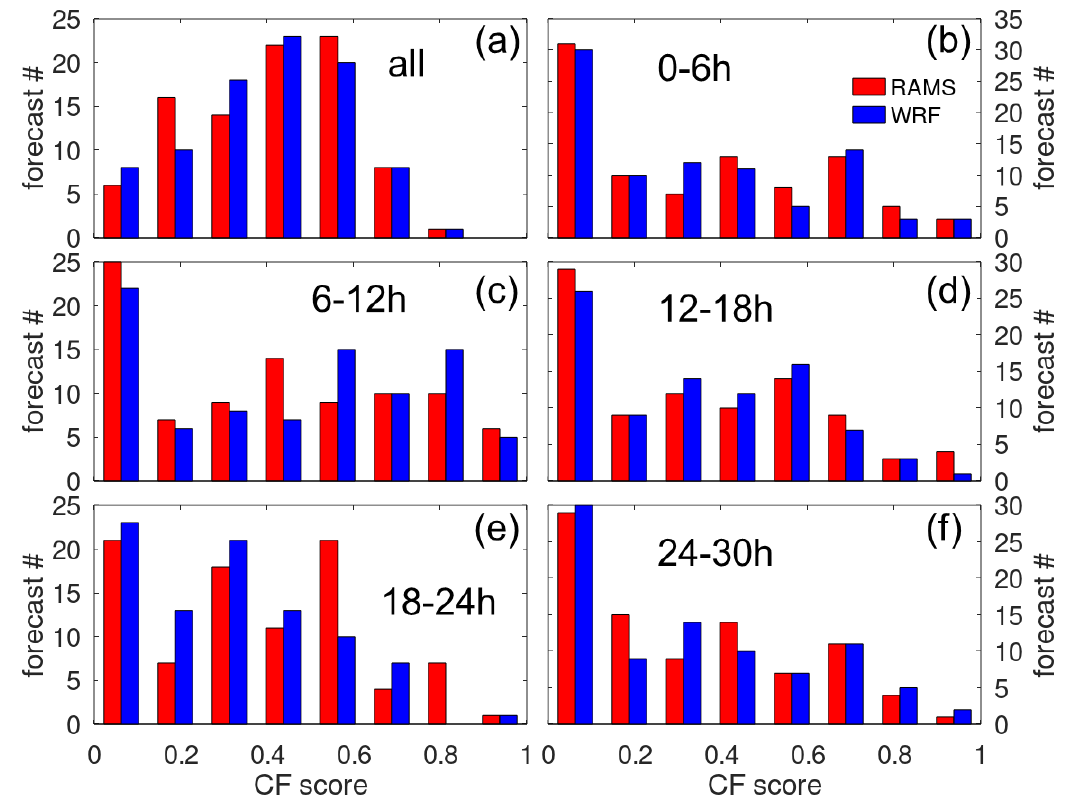
Figure 8. As in Figure 6 but for RAMS and WRF CF forecast scores.